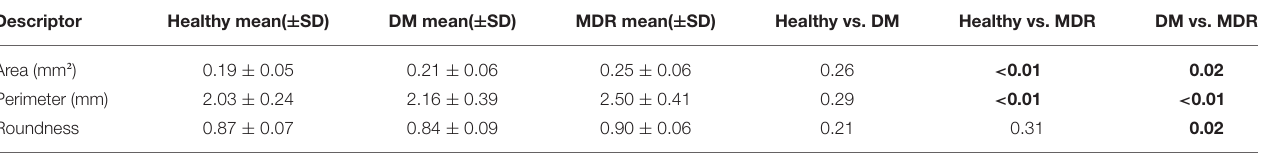
TABLE 2 | Results of the FAZ characterization for all three groups (first three columns show the morphological parameters).